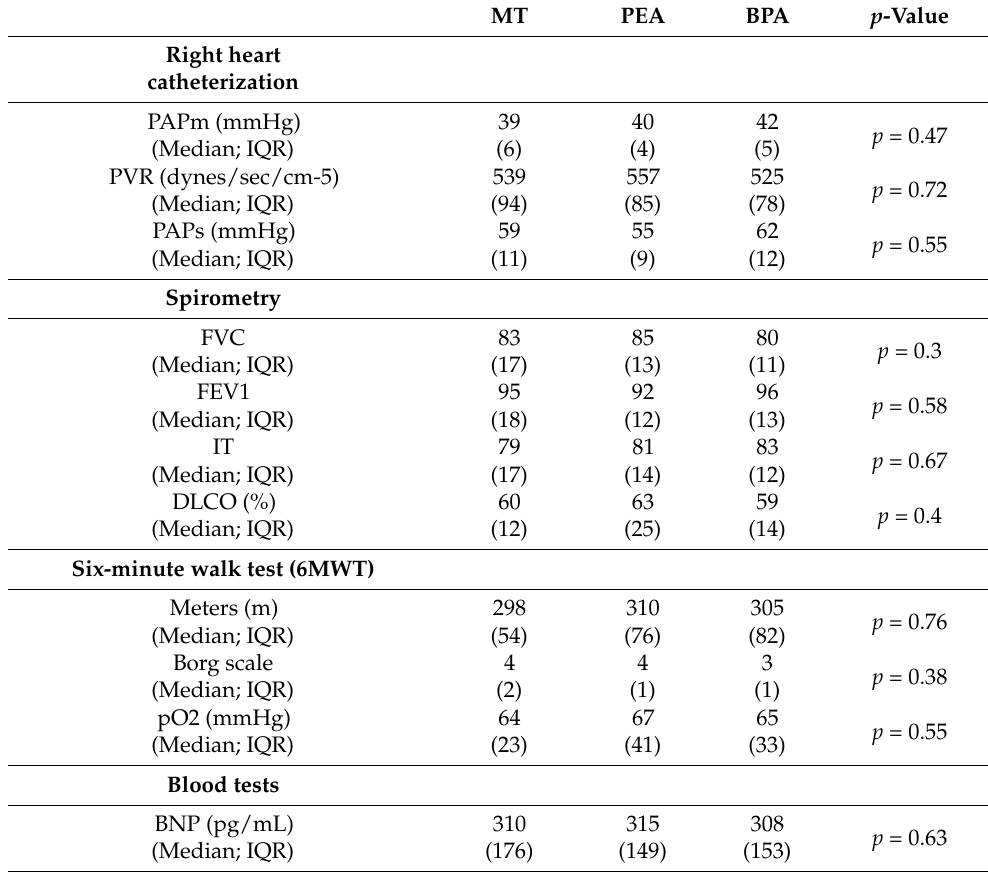
Table 3. Characteristics of the study population at enrollment. MT PEA BPA p